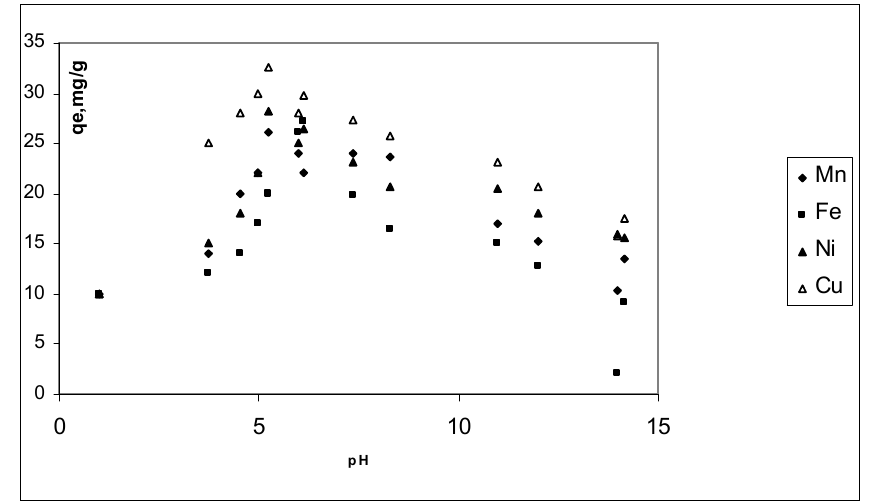
Figure 3. pH effect on CBC adsorption of Mn 2+ , Fe 2+ , Ni 2+ and Cu 2+ . Conditions: C 20 mg · L –1 ; CBC dose, 0.02 g; contact time, 20 min and temperature, 298